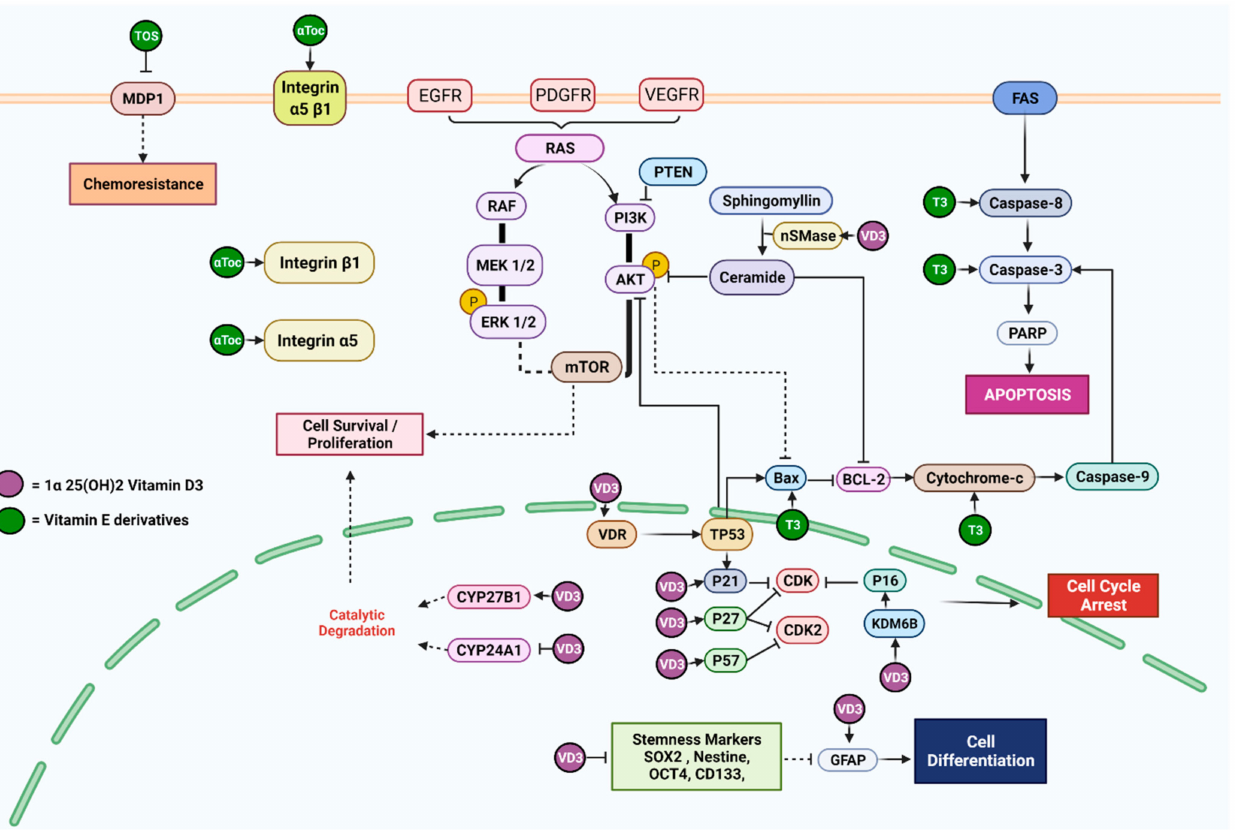
Figure 3. Illustration of the cellular pathways in GBM where vitamin D3 and vitamin E deriva- tives interact, identified from the systematic literature review of vitamin D3 [25–30] and vitamin E derivatives [31–35]. (Created with